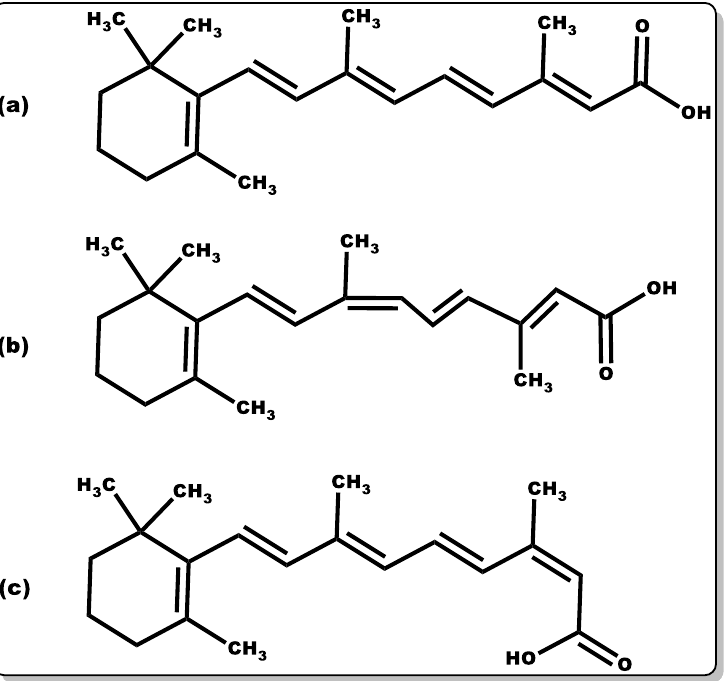
Figure 7. Molecular structure of retinoic acid in various isoforms: ( a ) all-trans-retinoic acid, ( b ) 9-cis-retinoic acid, and ( c ) 13-cis-retinoic acid.